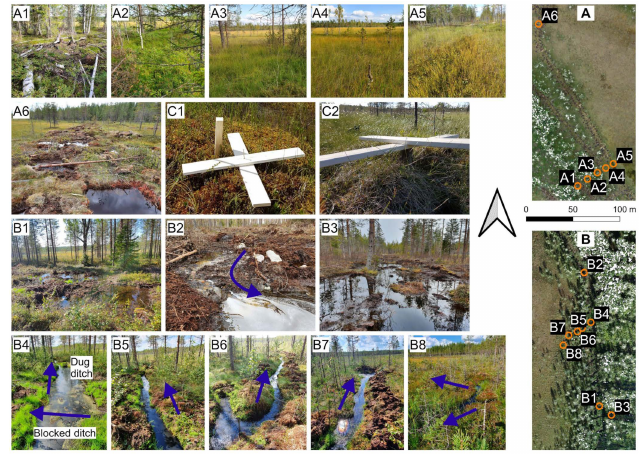
Figure 9. Field photographs and their shooting locations for the restoration sites of Loukkusuo ( A ) and Iso Leväniemi ( B ). The sequence ( A1 – A5 ) shows how the peatland surface develops when moving from the tree-covered area to the open peatland. ( A6 ) and ( B1 ) show the excavation footprint. ( B2 ) shows flow-derived erosion on the ditch infilled with organic and mineral soil. ( B3 ) shows the wide inundation during the high-water season after restoration. The sequence ( B4 – B8 ) shows how the water from the infilled ditch is directed to the open peatland through a manually-dug ditch. ( C1 ) shows a GCP not yet attached to the pole hit through the peat and ( C2 ) shows a GCP attached to a tree stump. The blue arrows represent the direction of water